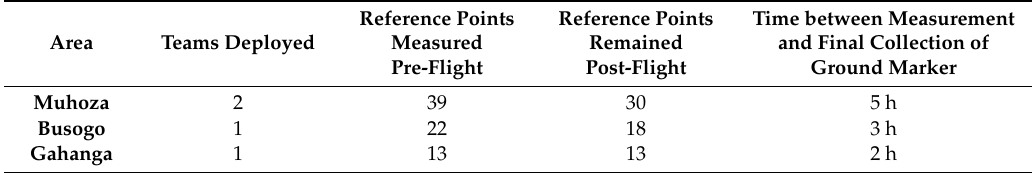
Table 5. Number of deployed reference points - count before and after the UAS